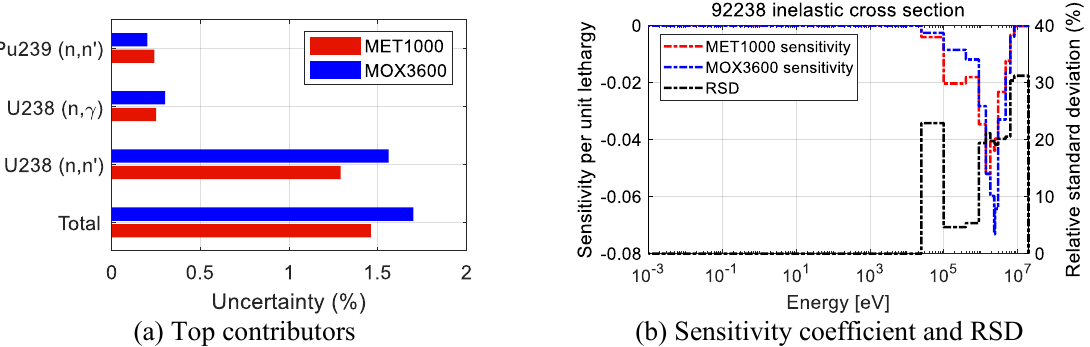
Figure 3. Uncertainty contributions to 𝒌